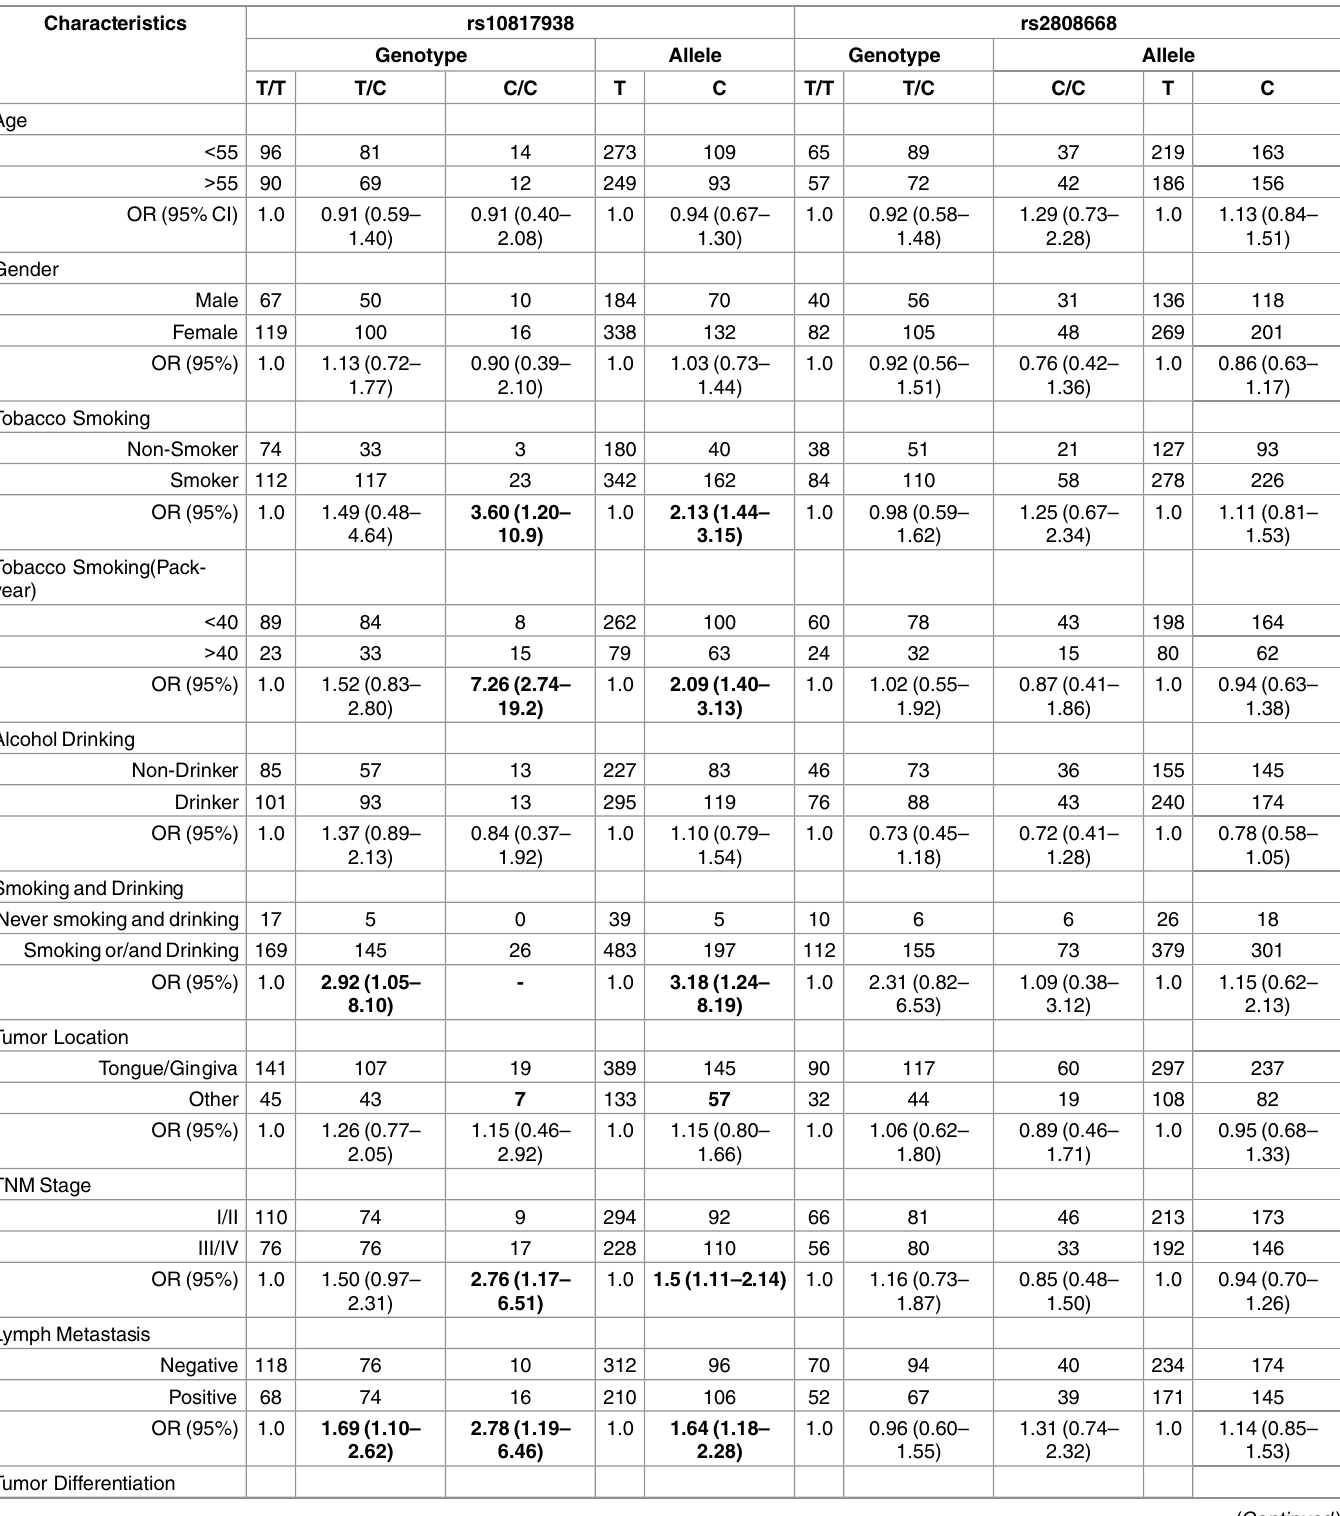
Table 3. Associationof rs10817938, rs2808668 polymorphismswithclinicopathologicalcharacteristicsof OSCC